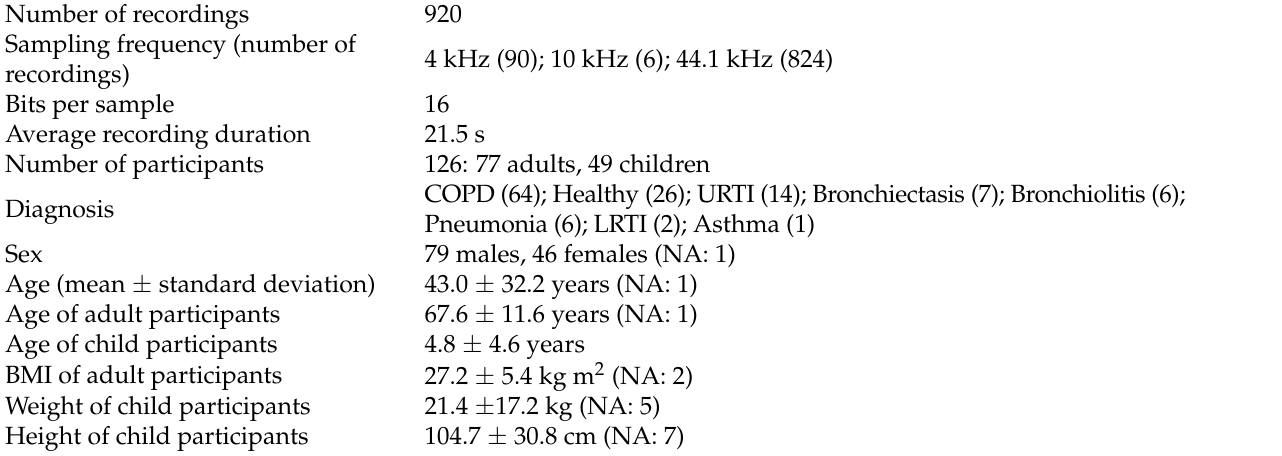
Table 2. Demographic information of the